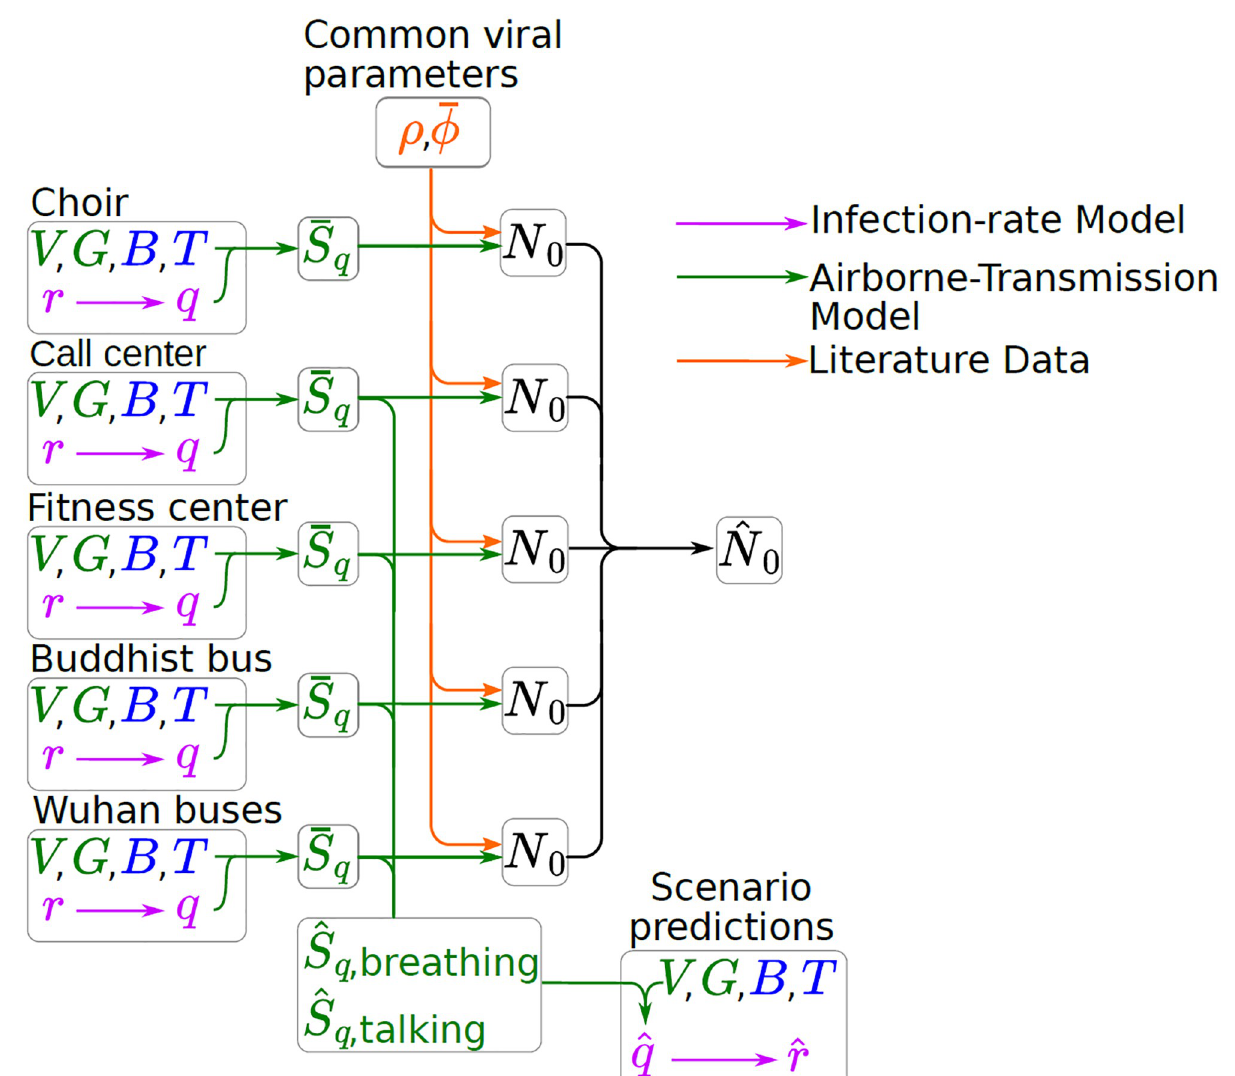
Fig 2. Flow chart illustrating the main conceptual thread of the paper, originating with raw data (either measured or inferred) from a series of case studies. The attack rate r from these data then fed into an infection-rate model (purple lines) which is used to estimate the inhaled quanta q for each case. A box airborne transmission model (green lines) is then used to calculate � S , the time-averaged rate of quanta emission from the index q (for each activity). We can use this estimate (1) to predict ^ r , the patient across the event. The mean of these values across cases is used to estimate ^ S q attack rate of a hypothetical future event, and (2) to infer ^ N by using literature values for infective load ρ and viral emission rate ^ � combined with the 0 estimated ^ S q